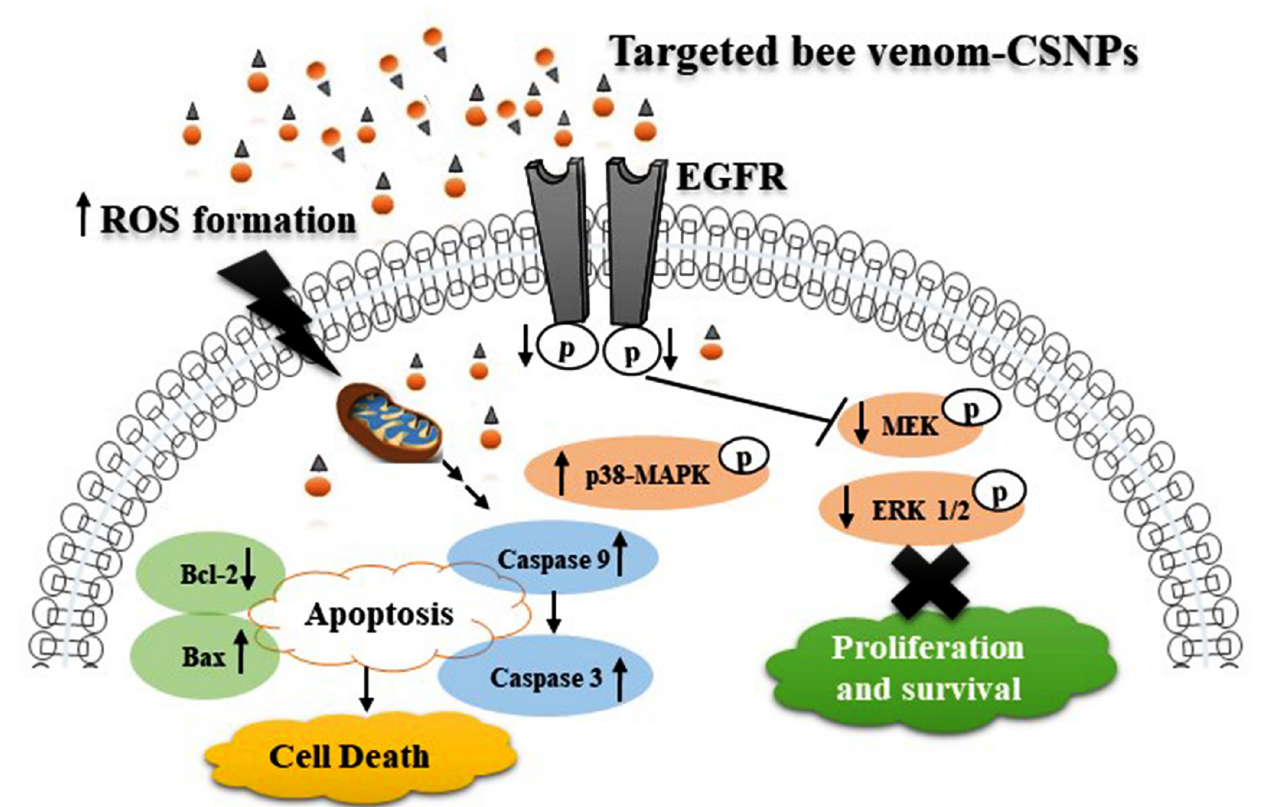
Fig 11. Schematic representation of the different pathways for targeted bee venom-CSNPs inside